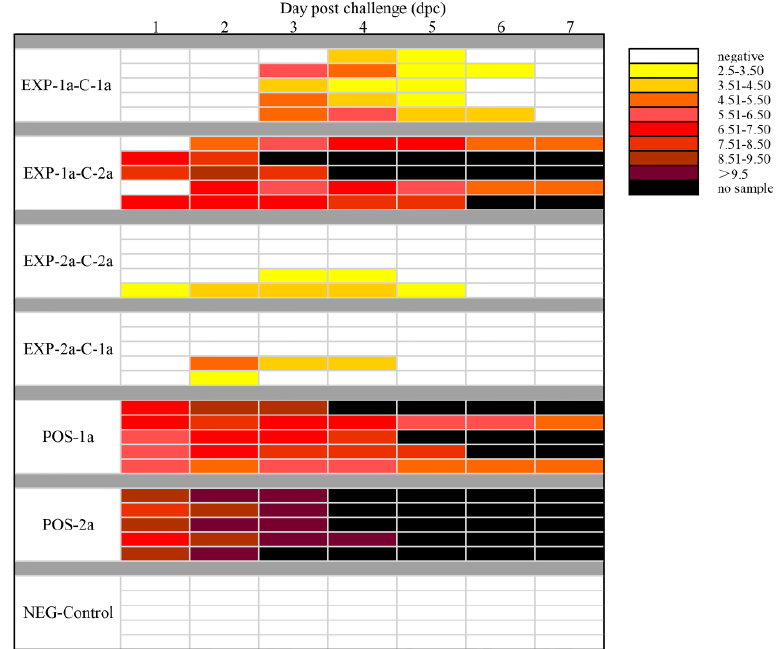
Figure 5. PEDV shedding patterns for all challenged piglets over time. For each group a line corresponds to the quantity of virus shed in rectal swabs for a single piglet from dpc 1 to dpc 7 is shown on the right side of the heatmap.